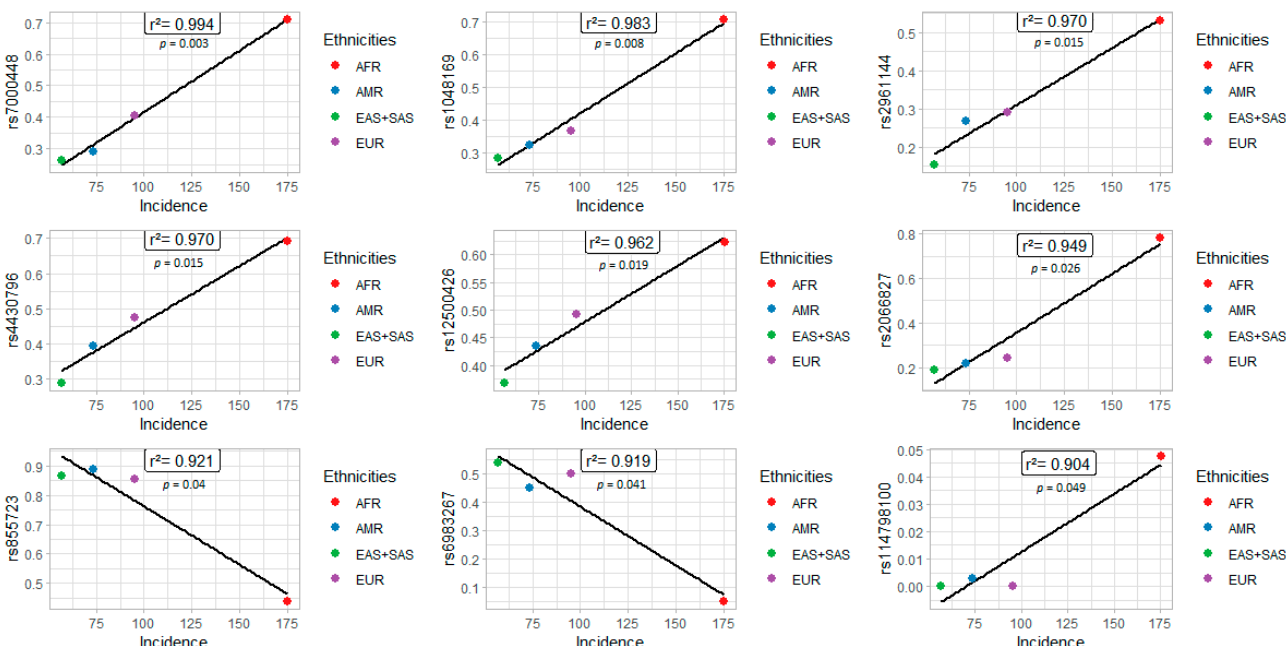
Figure 4. SNPs associated with prostate cancer incidence in different populations. Table 2. SNPs significantly correlated with PCa incidence in different populations.